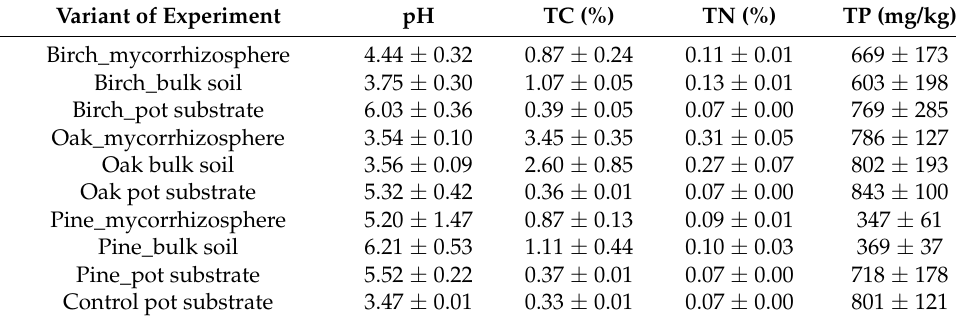
Table 4. Selected soil chemical parameters.